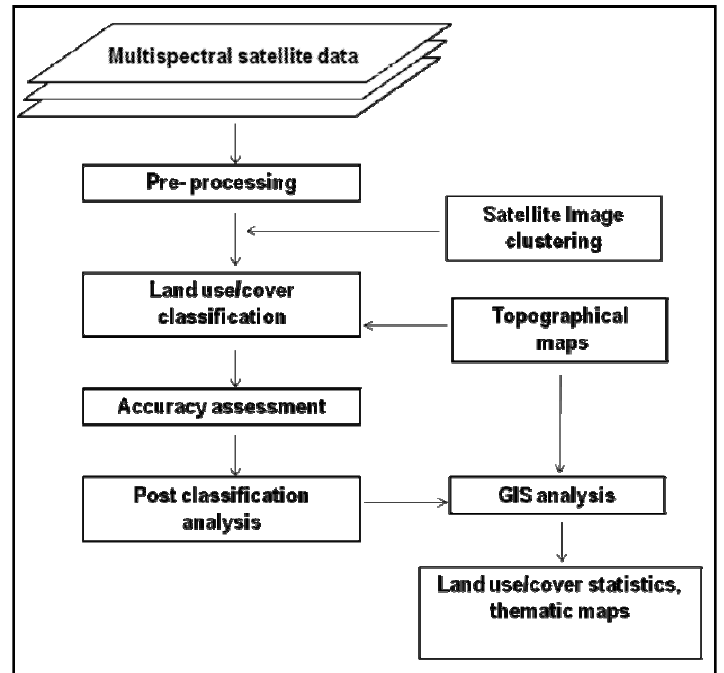
Figure 3. Study approach adopted for the analysis of land use/cover changes in Masai Mara